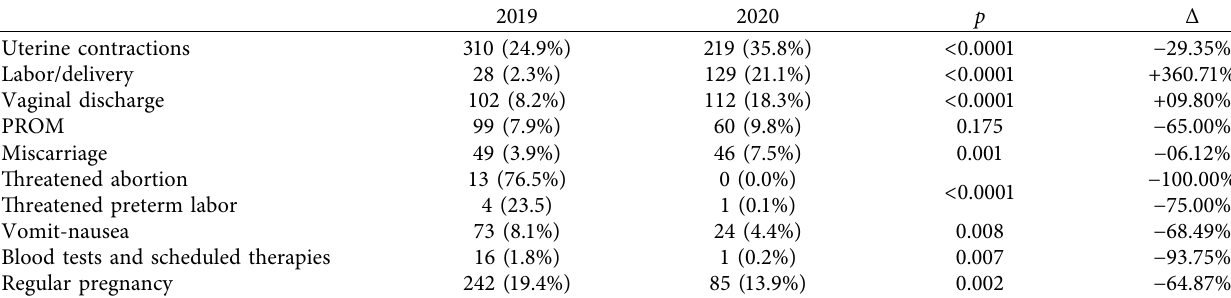
Table 6: Obstetrical patients’ specific admission and discharge.